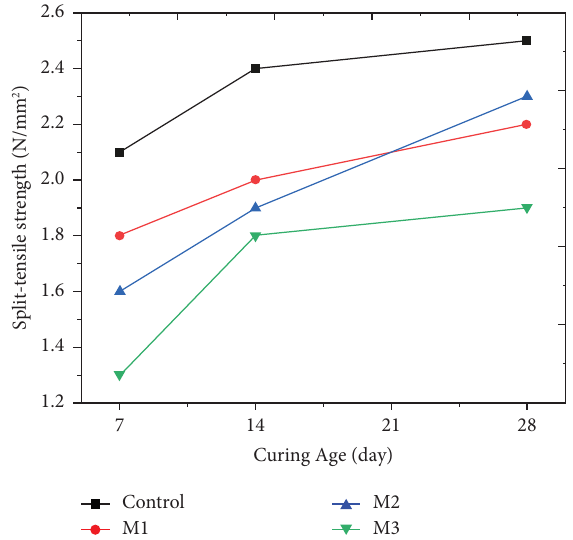
Figure 14: Split tensile strength for diferent curing